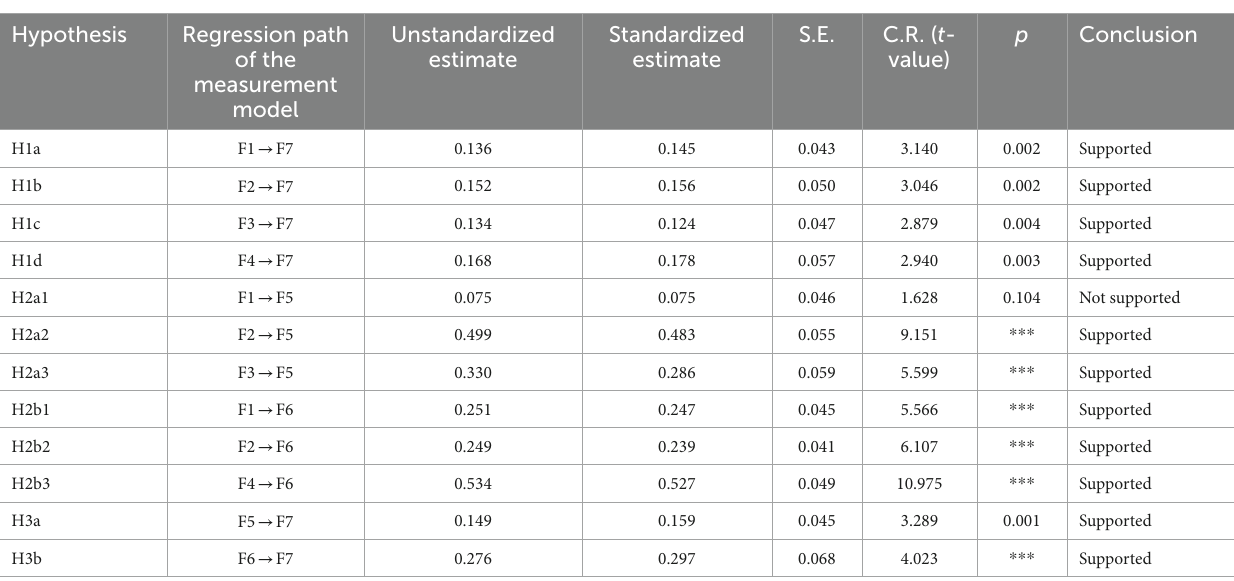
TABLE 3 Analysis results of paths between